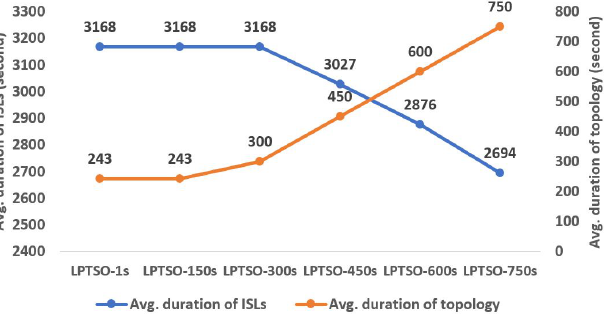
Figure 5. ISL and topology duration with different value of time segment